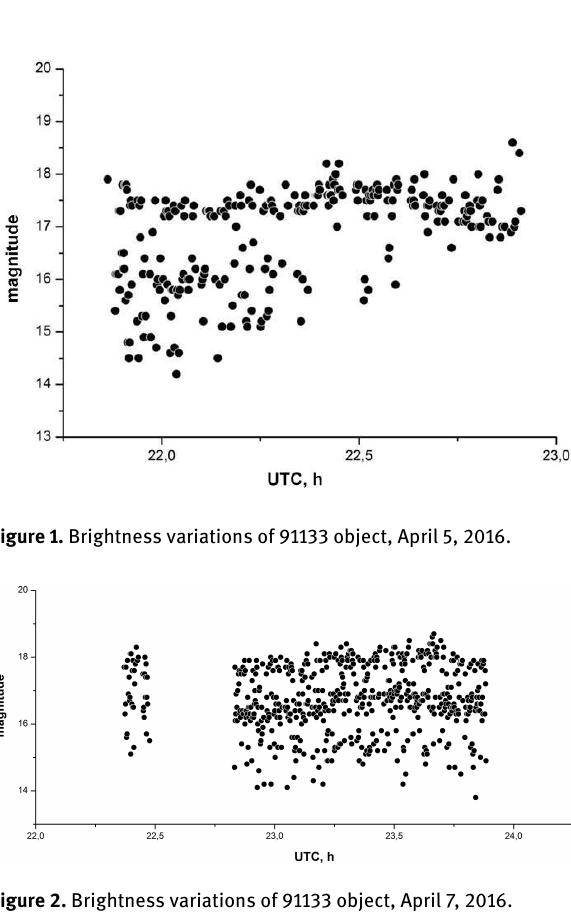
Figure 2. Brightness variations of 91133 object, April 7, 2016.